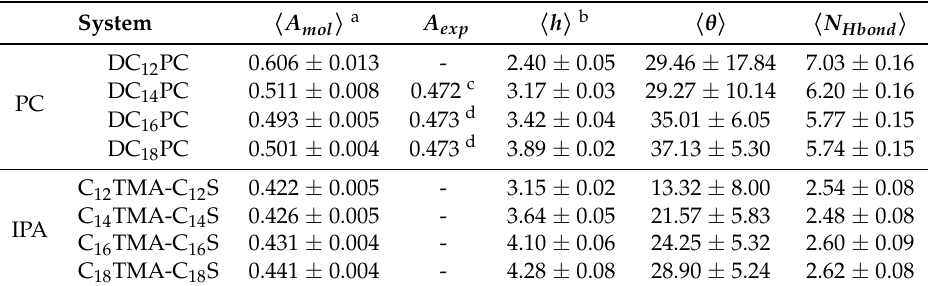
a nm 2 per molecule; b nm; standard deviations for (cid:104) h (cid:105) were evaluated from three independent MD runs; c measured at 283 K [44]; d measured at 298 K